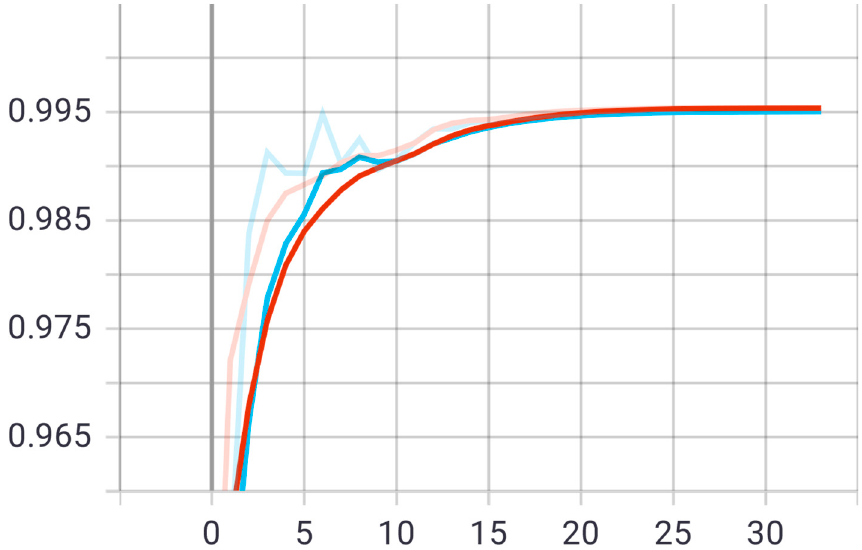
Figure 11. Accuracy (red line) and validation (blue line) convergence curves of the first model over 30 epochs.